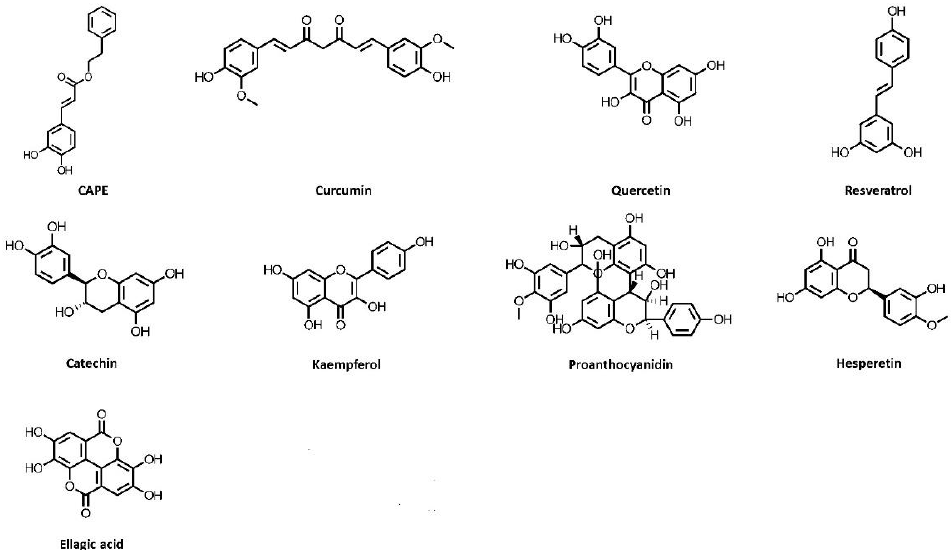
Figure 1. Chemical structures of polyphenols, which exhibit kidney-protective activities. CAPE, caffeic acid phenethyl ester.